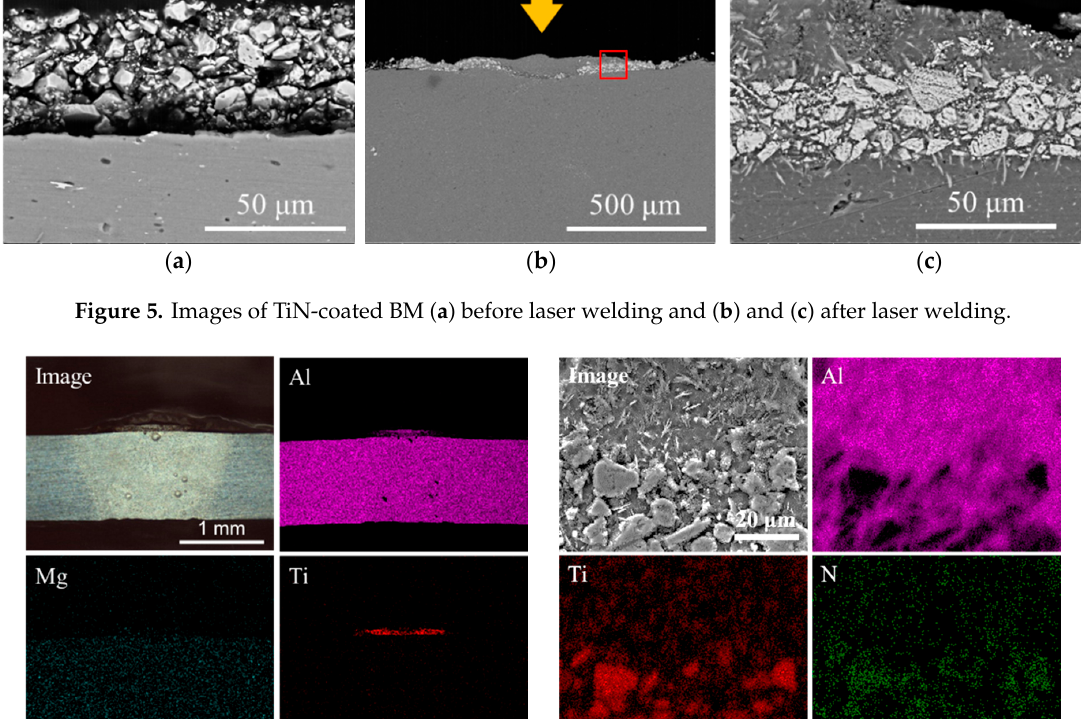
Figure 6. EDS mapping analysis of ( a ) the macro cross-section and ( b ) the top layer of laser-welded TiN-coated BM.